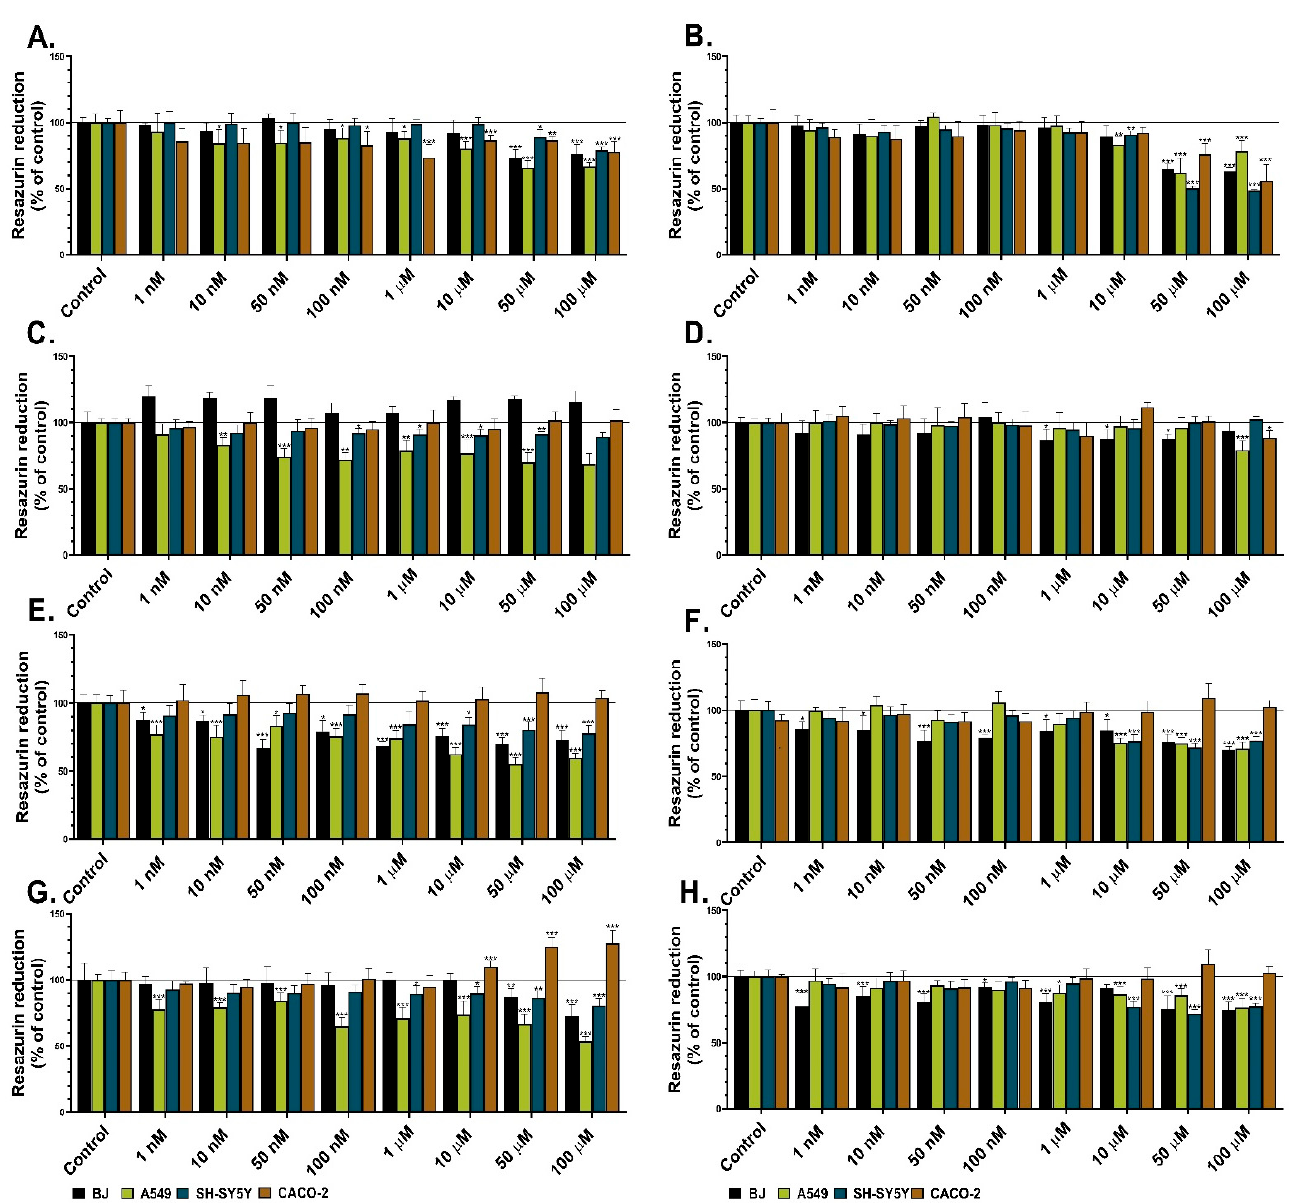
Figure 2. Metabolic activity of BJ, A549, SH-SY5Y, and CACO-2 cell lines after 24 h ( A , C , E , G ) and 48 h treatments ( B , D , F , H ) with Les-3166 ( A , B ), Les-5935 ( C , D ), Les-6009 ( E , F ), and Les-6166 ( G , H ). Mean values ( n = 6) with standard deviation (error bars) where *, **, and *** are statistically different from the respective (vehicle-treated) control at p < 0.05, p < 0.01, and p < 0.001, respectively (one-way ANOVA, Tukey’s test).